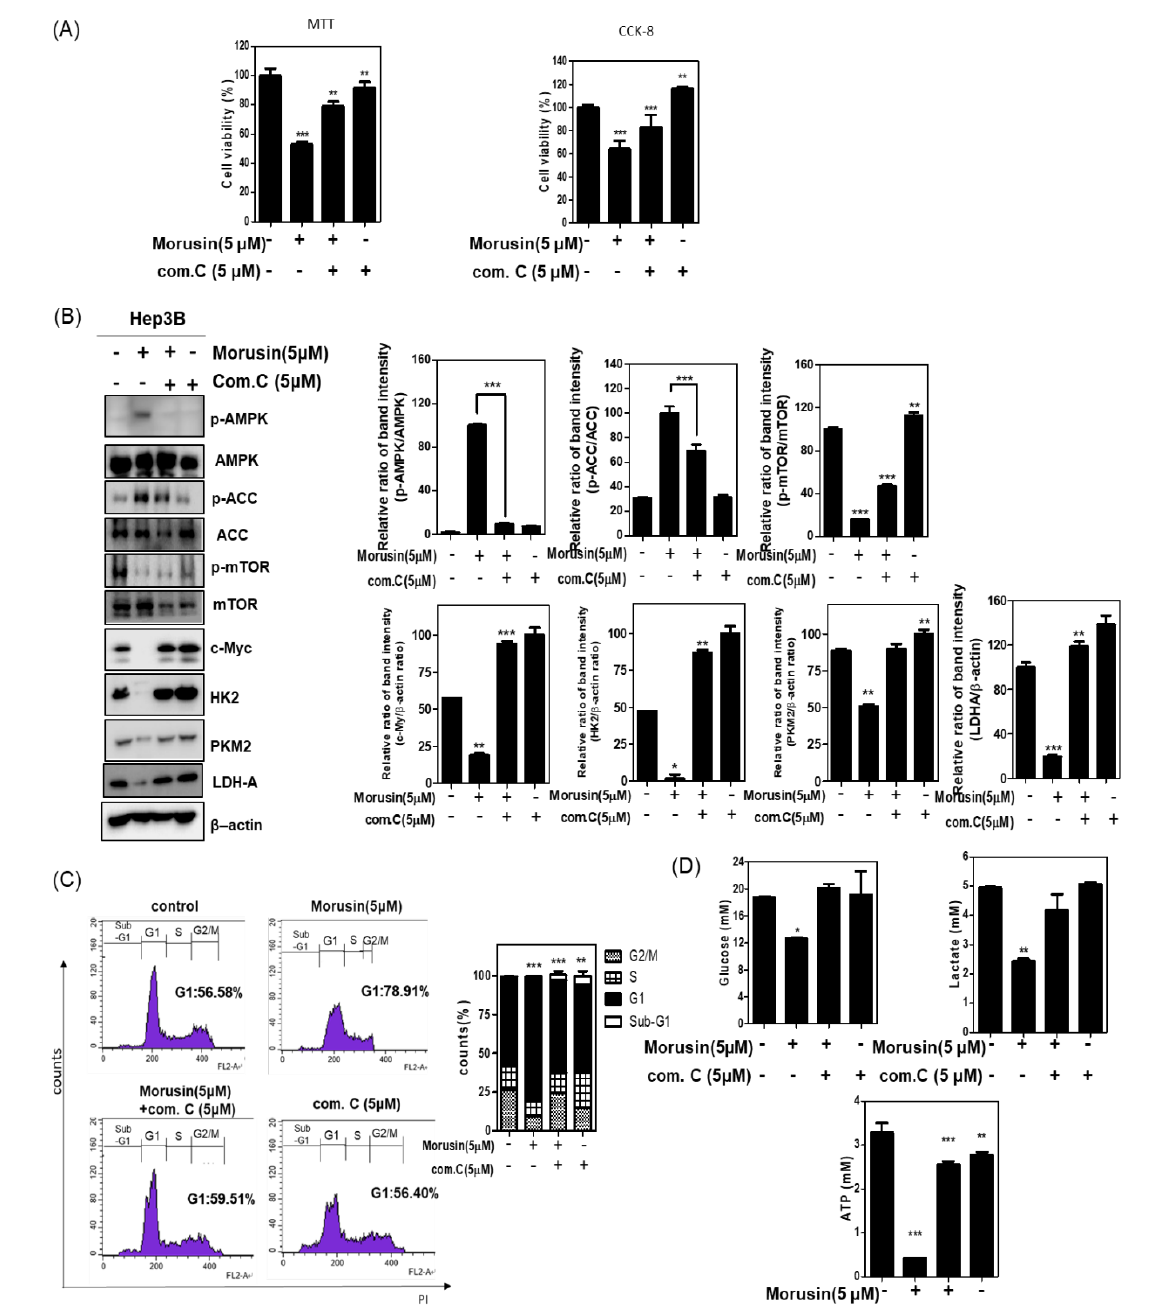
Figure 4. Effect of compound C on glycolysis related proteins and G1 arrest in Morusin treated Hep3B cells. ( A ) Hep3B cells were treated with Moursin in the absence and presence of compound C. Cell viability was evaluated using MTT and CCK-8 assays. ( B ) Effect of AMPK inhibitor compound C on glycolysis related proteins in Morusin treated Hep3B cells. Hep3B cells were treated with Morusin (5 µ M) in the presence or absence of compound C (5 µ M) for 24 h. Cell extracts were prepared and subjected to Western blotting with the antibodies of p-mTOR, mTOR, p-ACC, ACC p-AMPK, AMPK, c-Myc, HK2, PKM2, and β -actin. Data represent means ± SD. *, p < 0.05, **, p < 0.01, ***, p < 0.001 vs. untreated control. ( C ) Effect of compound C on G1 arrest in Morusin treated Hep3B cells. Hep3B cells exposed to Morusin (5 µ M) in the presence or absence of compound C for 24 h were subjected to cell cycle analysis by staining with propidium iodide (50 µ g/mL) ( n = 3). ( D ) Glucose, lactate, and ATP in conditioned medium were measured by using colorimetric assay kit. Data represent means ± SD. *, p < 0.05, **, p < 0.01, ***, p < 0.001 vs. untreated control ( n =